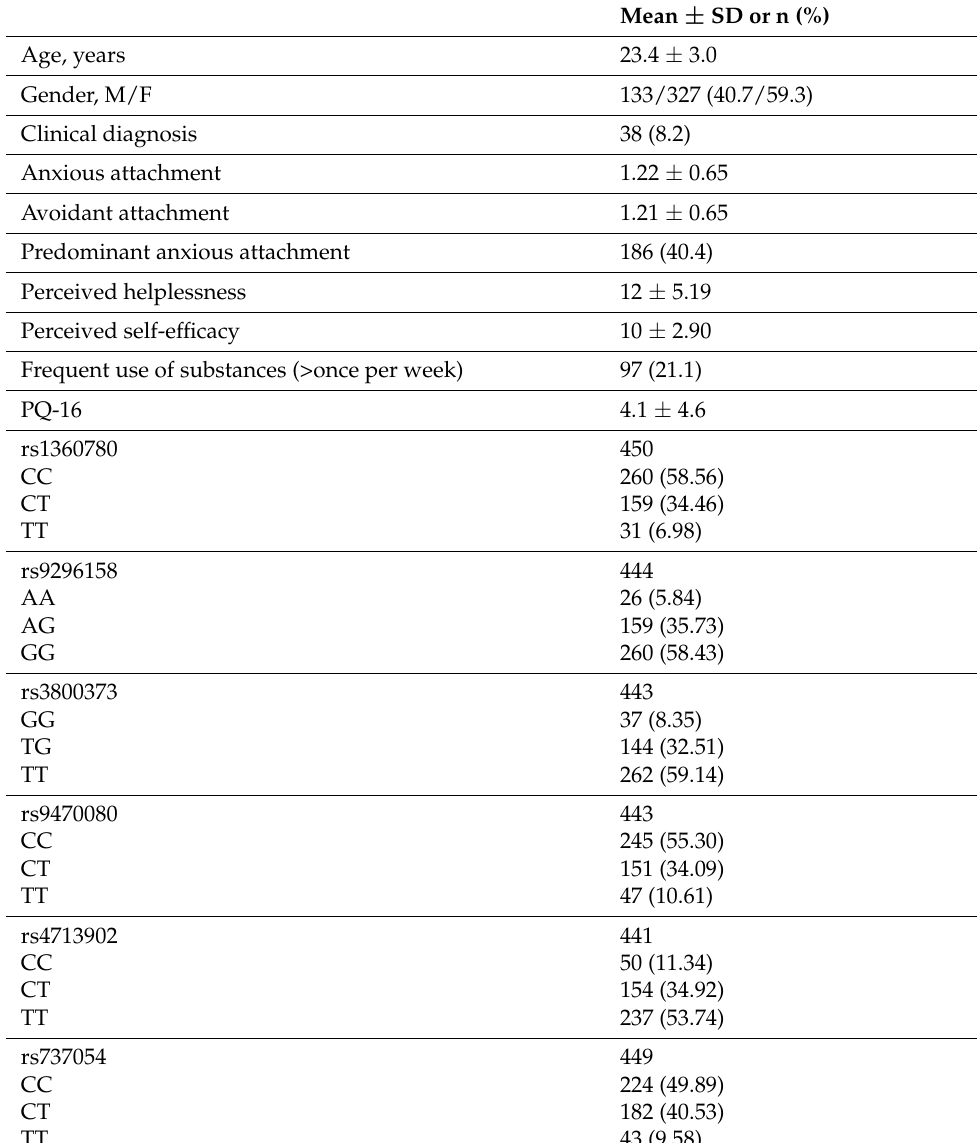
Table 1. General characteristics of the